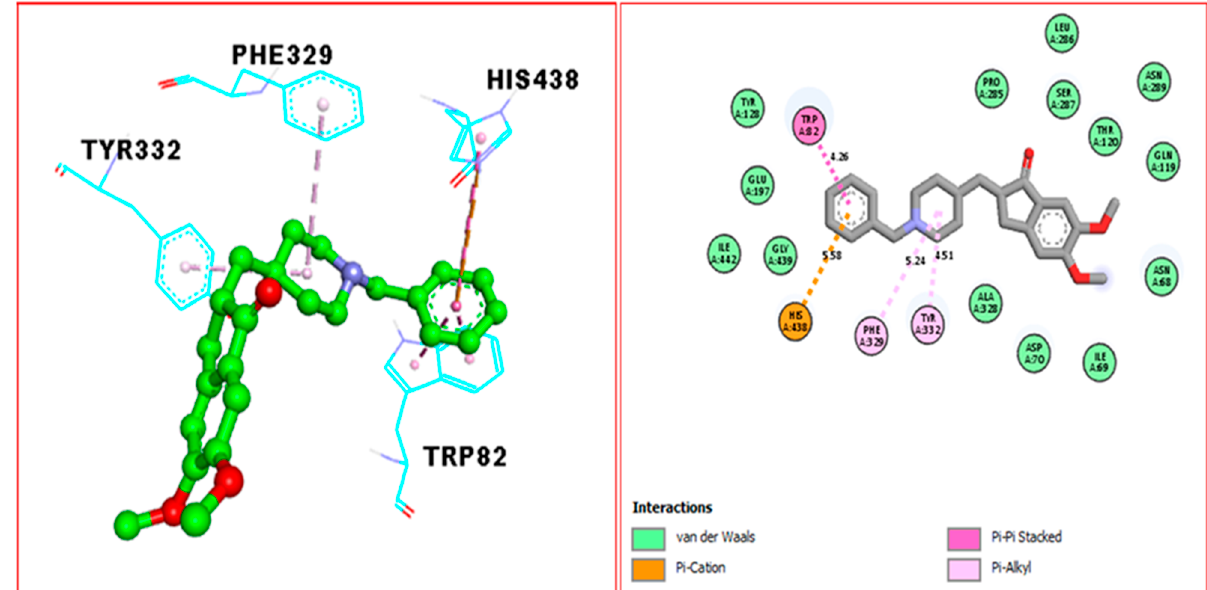
Figure 14. Representation of the PLI profile for donepezil against BuChE. Table 2. Protein–ligand interaction profile for most potent compounds ( 1 and 10 ) and standard drug .